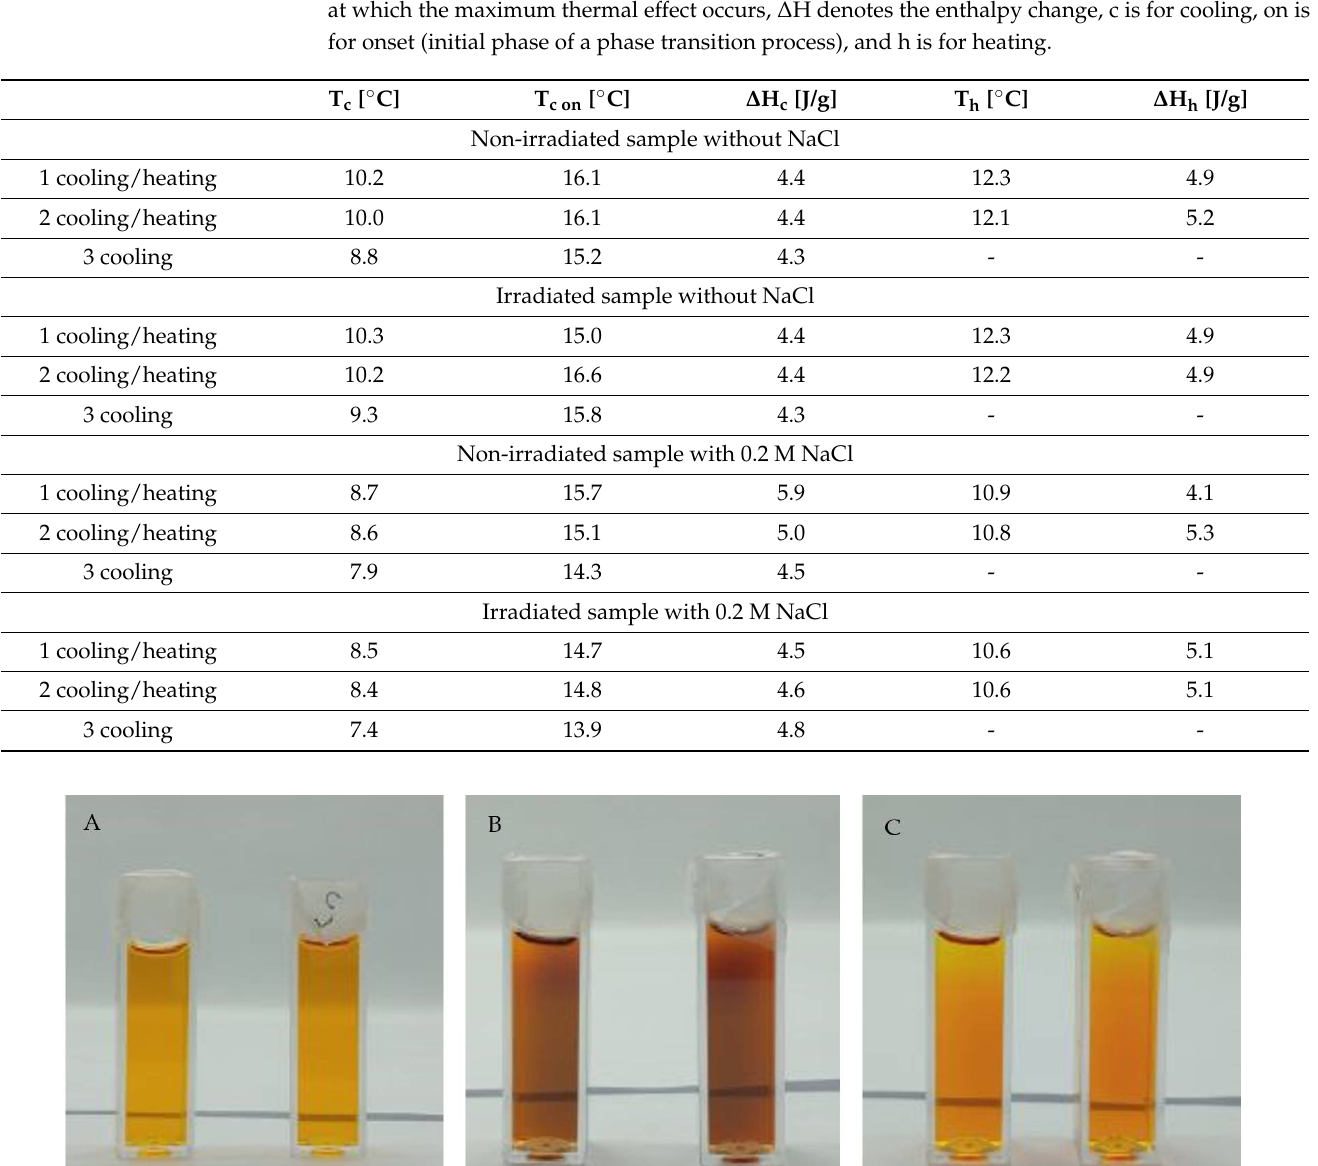
Figure 3. Photographs of the Fricke-XO-Pluronic F-127 dosimeter samples without and with 0.2 M NaCl, which were stored at room temperature and exposed to daylight: ( A )—immediately after preparation, ( B )—24 h, ( C )—48 h. The samples on the right-hand side contain